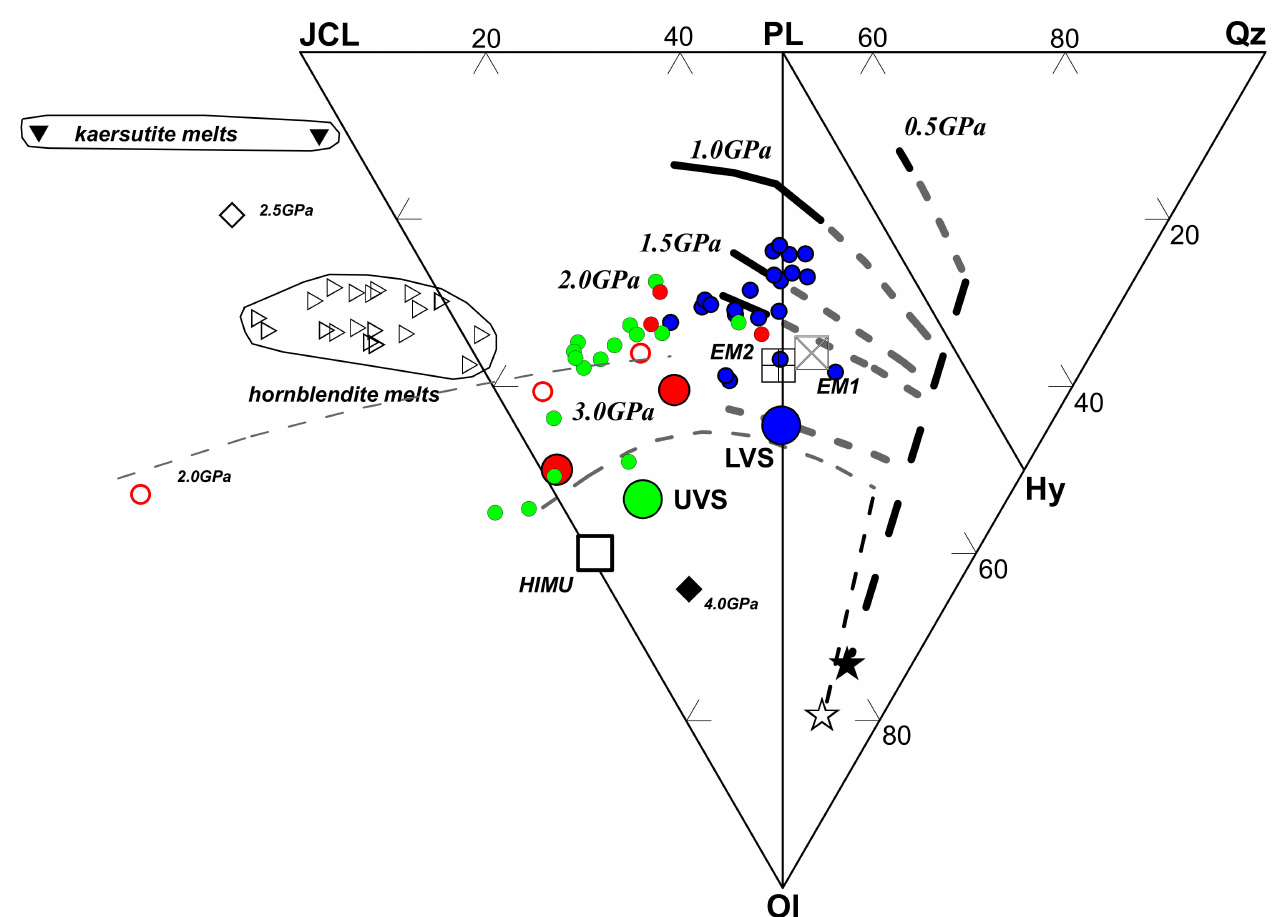
Figure 17. Calculated parental magmas for the Christmas Island lava series (Table 4, large green circle—UVS, large blue circle—LVS) and for petit-spot magmas from the Hokkaido Rise (large red circles; [162]) plotted in the projection from diopside onto the base of the CIPW molecular normative ‘basalt tetrahedron’. Normative components as follows: Ol, olivine; Qz, quartz; Hy, hypersphene; Pl, Ab + An + Or (Ab, albite; An, anorthite; Or, orthoclase); JCL, Jd + CaTs + Lc (Jd, jadeite; CaTs, Ca-Tschermaks; Lc, leucite). The position of the parental magmas is compared to experimentally determined melting cotectics for Hawaiian pyrolite (open star) from 0.5–3 GPa under nominally volatile free conditions [155] and for peridotite (PERC3; filled star) under CO 2 under-saturated conditions at 3 GPa [151]. Solid cotectic lines are melts in equilibrium with a lherzolite residue; grey dashed cotectic lines are melts in equilibrium with a harzburgite residue and black dashed cotectic lines are melts in equilibrium with a dunite residue. Other symbols and fields are as follows: small blue circles—LVS lava >9 wt% MgO; small green circles—UVS lava >9 wt% MgO; small filled red circles—petit-spot lava from the Hokkaido Rise with >9 wt% MgO [27]; HIMU, EMI, EMII are calculated parental melts for mantle-end members from [56]); small red open circles are melts in equilibrium with harzburgite from the experiments of Machida et al. [162] (see also Supplementary Discussion); open and filled diamonds are the near-solidus melts for HZ1 peridotite [163] under H 2 O- saturated conditions at 2.5 and 4 GPa respectively [154]; right facing open triangles are experimentally determined melts of amphibole bearing mantle lithologies from [153]; filled upside triangles are natural glass in mantle xenoliths resulting from the melting of amphibole